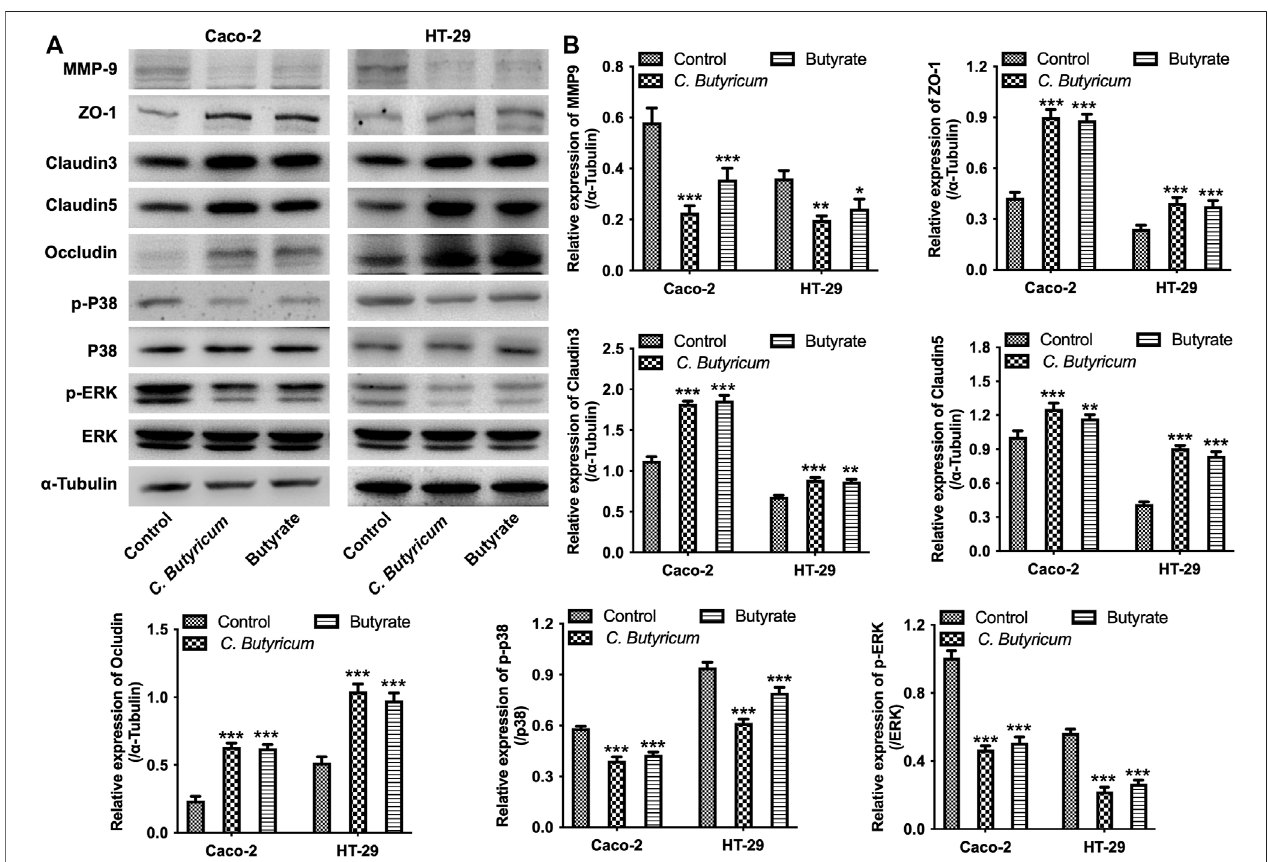
FIGURE 3 | Clostridium butyricum or butyrate treatment reduced MMP9 expression and upregulated the expressions of tight junction proteins in Caco-2 and HT- 29cells. (A,B) Caco-2andHT-29cellsweretreatedwithbutyrate (2 mMforCaco-2celland1 mMforHT-29cell)for48 h.Meanwhile,Caco-2andHT-29cellswereco- cultured with C. butyricum (1 × 10 8 CFU/ml) for 6 h in an anaerobic environment. After that, the supernatant was removed, and cells were then cultured in normoxia environment for 48 h. Western blot assay was used to determine the expressions of MMP9, ZO-1, Claudin3, Claudin5, Occludin, p-p38, p-ERK in cells. * p < 0.05, ** p < 0.01, *** p < 0.001 vs. control group. MMP9, matrix metallopeptidase 9; ZO-1, Zona occludens